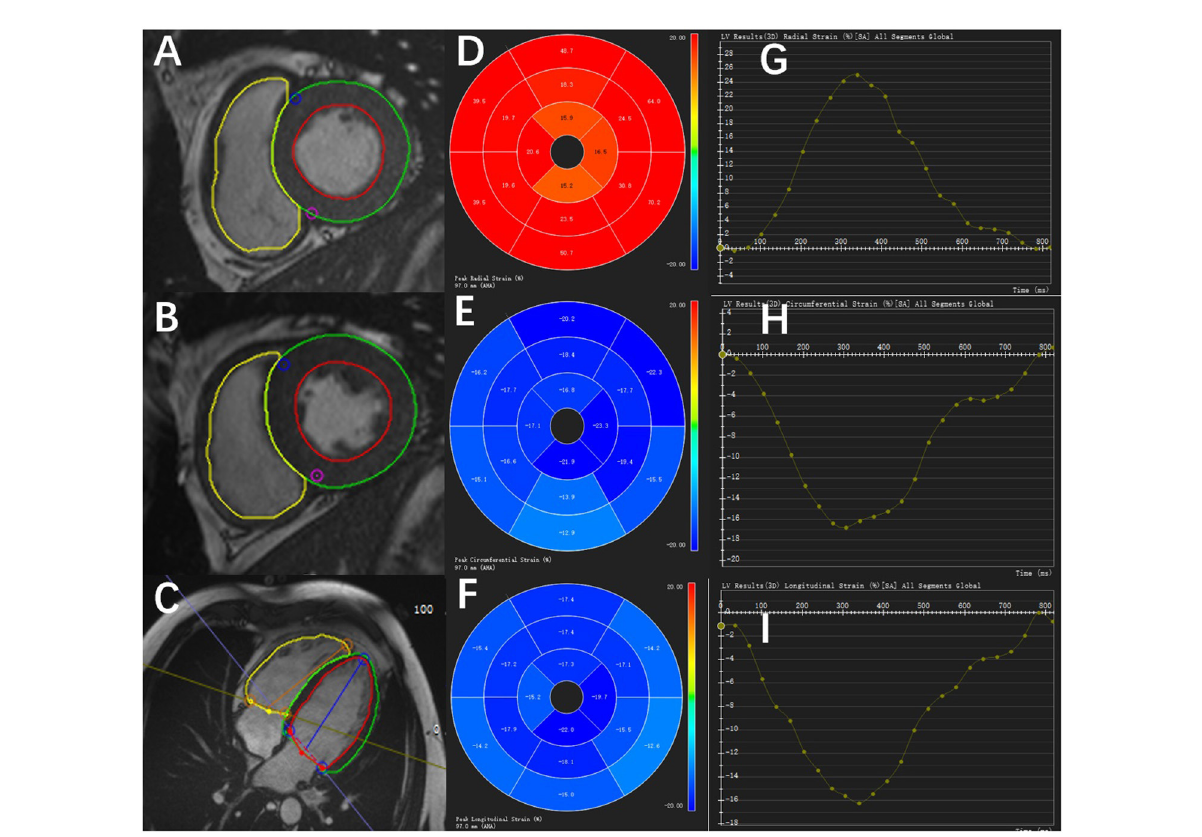
FIGURE2 Diagram of the peak systolic strain analysis of the left ventricular myocardium in a healthy control by CVI42 software. The left shows the endocardial and epicardial borders of different short-axis slice cine images (A,B) and long-axis cine image (C) . In the middle is the 16-segment model of the radial (D) , circumferential (E) , and longitudinal (F) values in a cardiac cycle. On the right are the strain–time curves of the radial (G) , circumferential (H) , and longitudinal (I) values in a cardiac